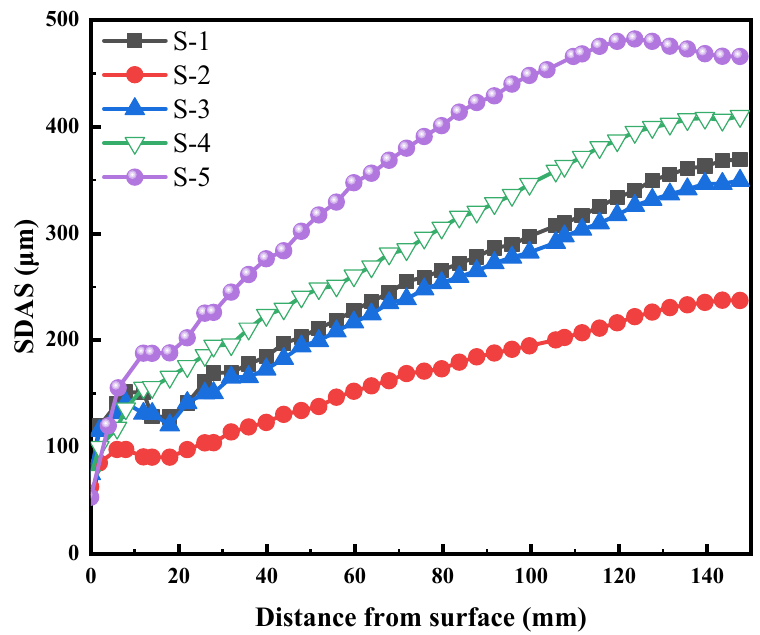
Figure 16. SDAS at different positions from the slab surface of different slabs.